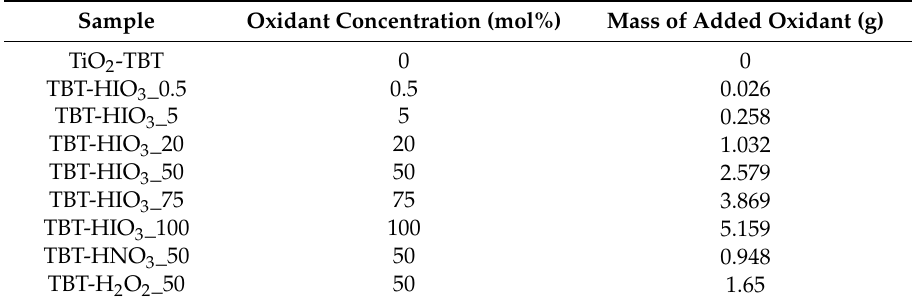
Table 1. The oxidant concentration used for preparation of the defective TiO 2 photocatalyst.